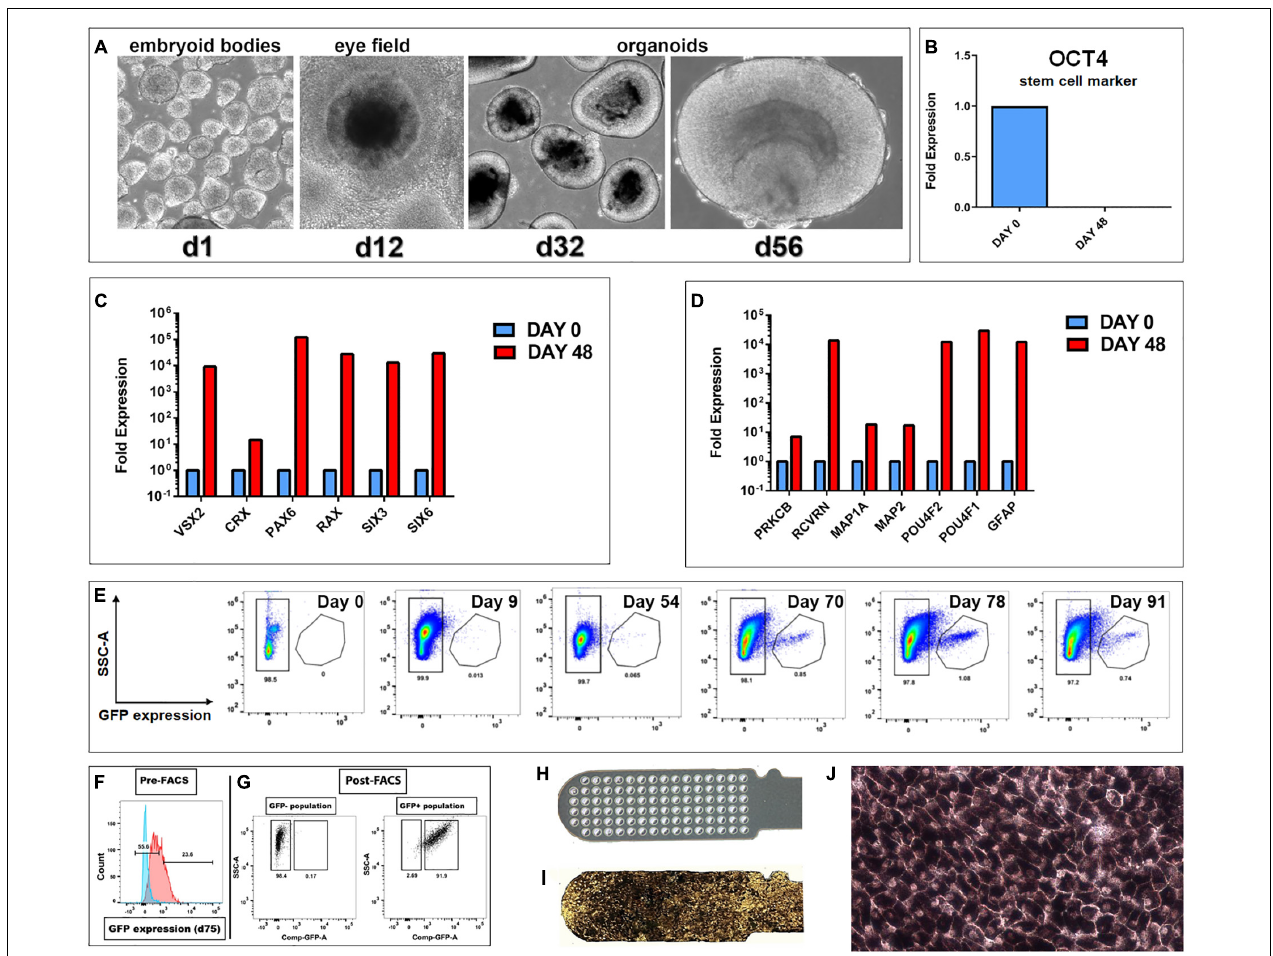
FIGURE 1 | Generation of hESC derived retina organoids (CRX-GFP cell line) and RPE (H9 cell line). (A) Phase contrast images of organoid development up to day 56. (B–D) Progenitor gene expression analysis of CRX-GFP hESC-derived retina organoids ( n = 2) and undifferentiated stem cells ( n = 1). (B) OCT4 expression is absent in differentiated day 48 retina organoids. (C) Retina organoids (red) highly express genes indicative of primitive retina and photoreceptor progenitors. (D) Markers for mature, terminally differentiated retinal subpopulations. Retina organoids (red) contain markers for all the major retinal cell types, including photoreceptor progenitors, glia, ganglion cells, bipolar, horizontal, amacrine, and Müller cells. (E) Flow analysis shows that GFP expression is absent in the undifferentiated stem cells, early embryoid bodies, and young retina organoids. A distinct GFP+ population appears at day 70. Expression is highest day 78 and persists in the oldest analyzed day 91 organoids. (F) Examples of gates drawn used for FACS sorting of the GFP negative and GFP positive populations. (G) Post-FACS purities > 90%. Cells were gated based on singlets, SSC vs. FSC profile, and if they were DAPI negative. Negative controls were undifferentiated CRX-GFP hESC (day 0). (H) Parylene only implant (no cells). (I) CPCB-RPE1 implant covered with hESC-RPE cells. (J) Enlargement of (I) to show details of hESC-RPE cells forming an epithelium (28–35 days